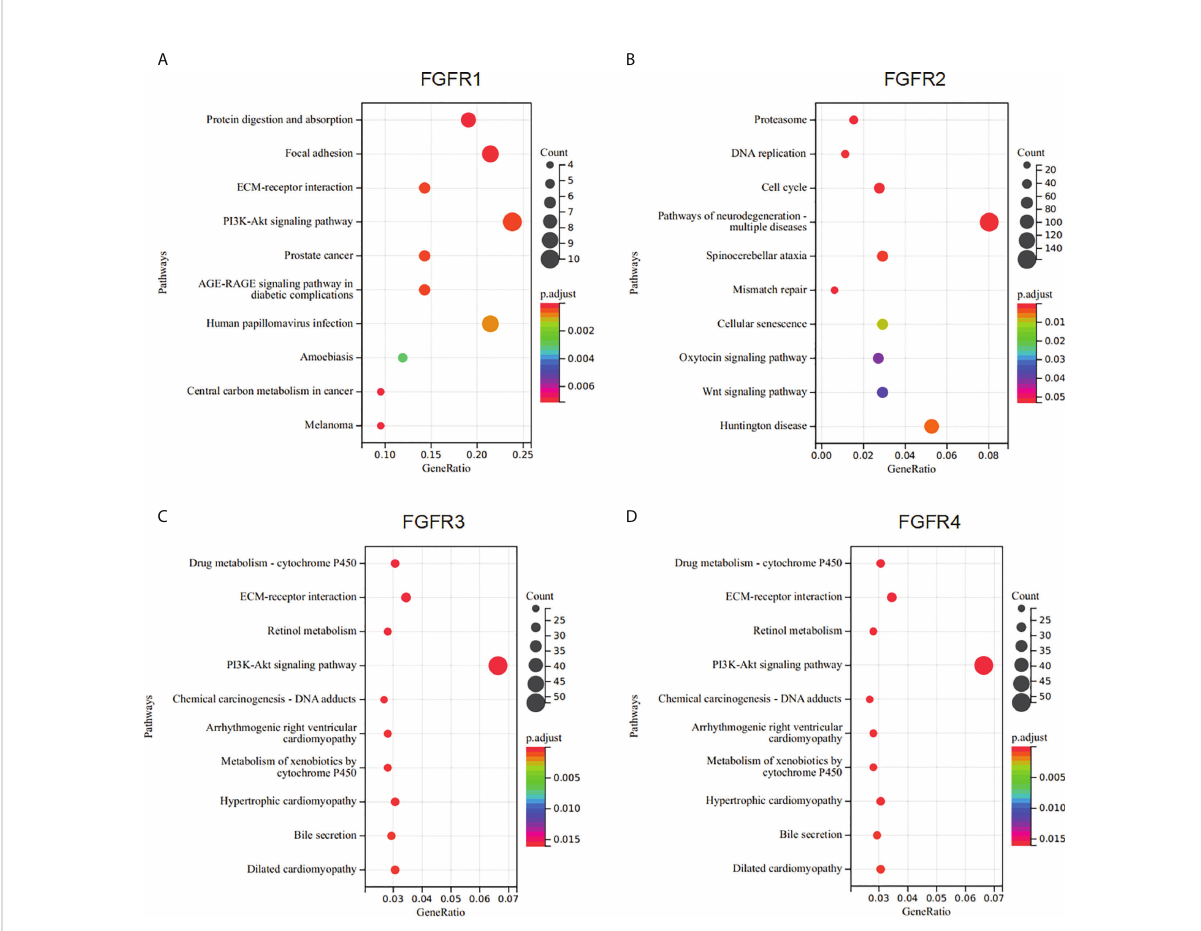
FIGURE 4 Enrichment analysis of FGFRs co-expression genes in GC. (A – D) The functions of genes signi fi cantly associated with FGFR1 (A) , FGFR2 (B) , FGFR3 (C) , and FGFR4 (D) alterations were predicted by the enrichment analysis of KEGG. GC, gastric cancer; KEGG, Kyoto Encyclopedia of Genes and